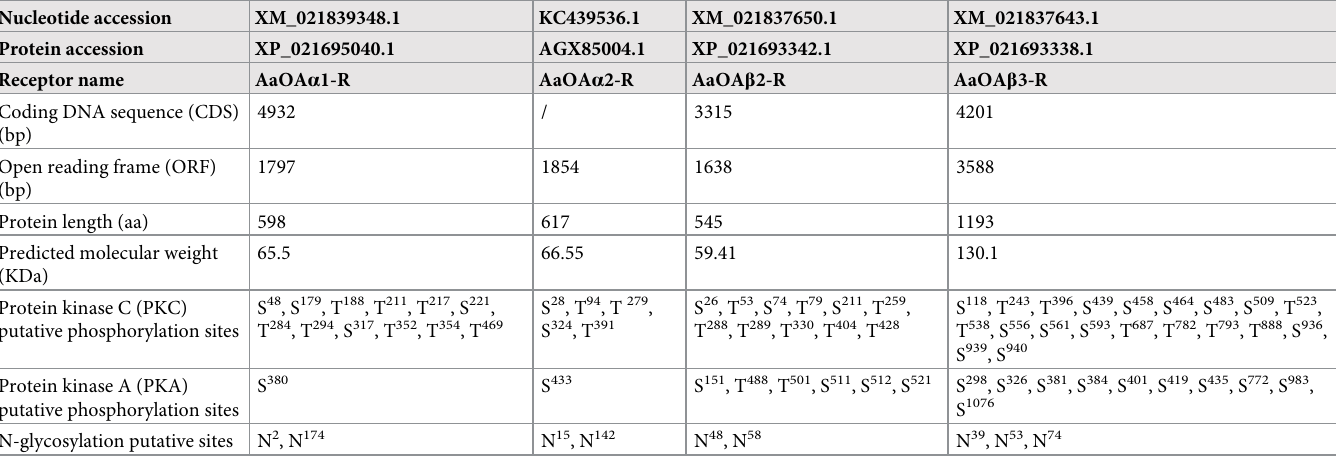
Table 1. OA receptors identified and characterized in A . aegypti . Nucleotide